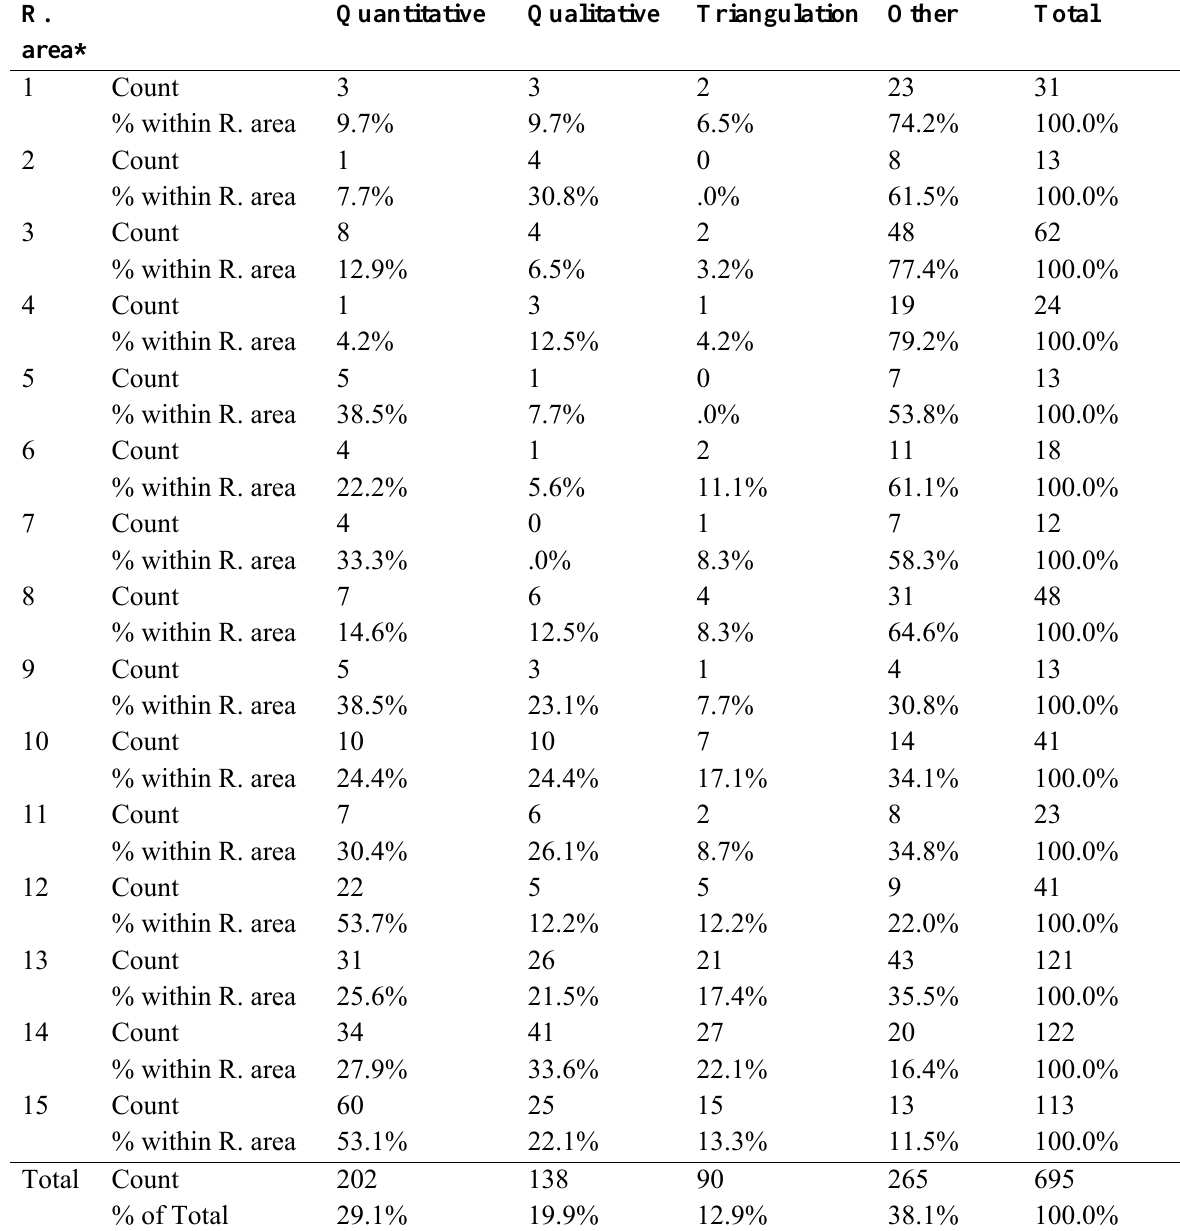
Table 7 Frequency Tabulation of Methods by Research Area (N = 695)